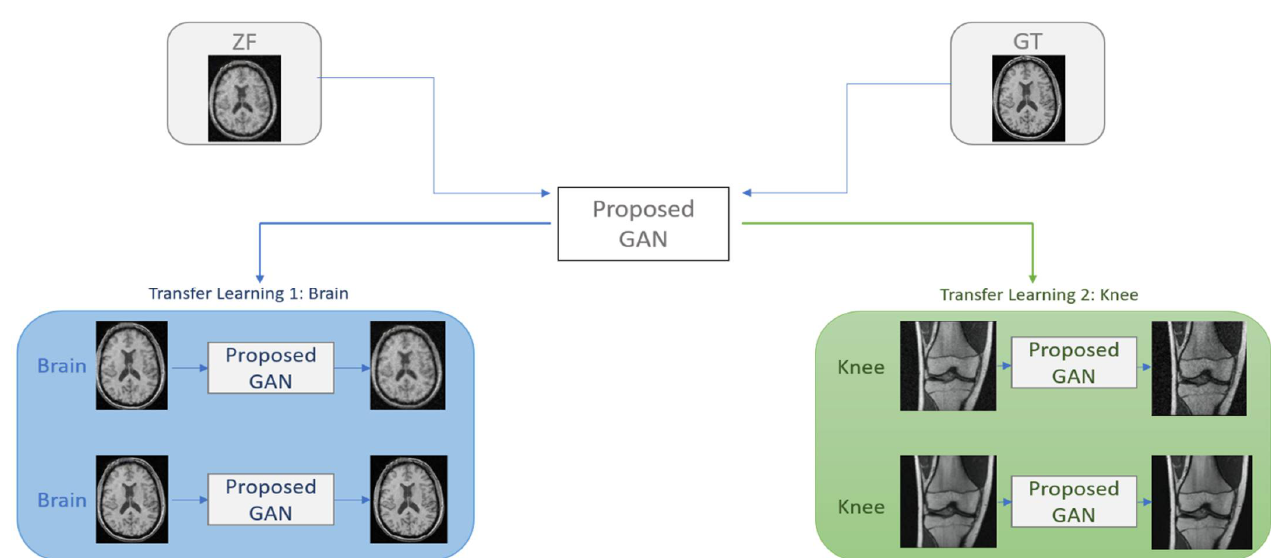
Figure 5. Transfer learning for a GAN reconstruction model proposed for under-sampled MRI re- construction.